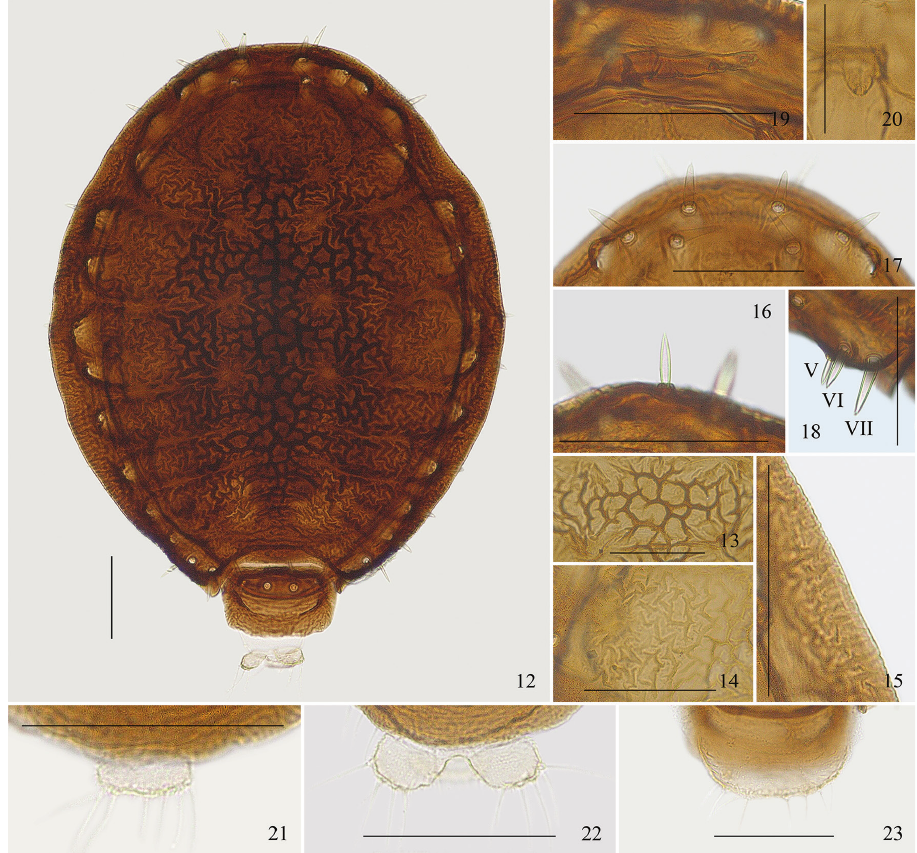
Figures 12–23. Parathoracaphis spinapilosa sp. n. Apterous viviparous female: 12 dorsal view of body 13 convoluted markings on medial area of prosoma dorsum 14 short folded-line shaped sculptures on pleuro-marginal area of prosoma dorsum 15 short transversely striped band on margin of prosoma 16 spine-like frontal seta on head 17 3 pairs of submarginal setae on head dorsum 18 submarginal setae on abdominal tergites V–VII 19 antenna 20 ultimate rostral segment 21 cauda 22 anal plate 23 genital plate. Scale bars: 0.10